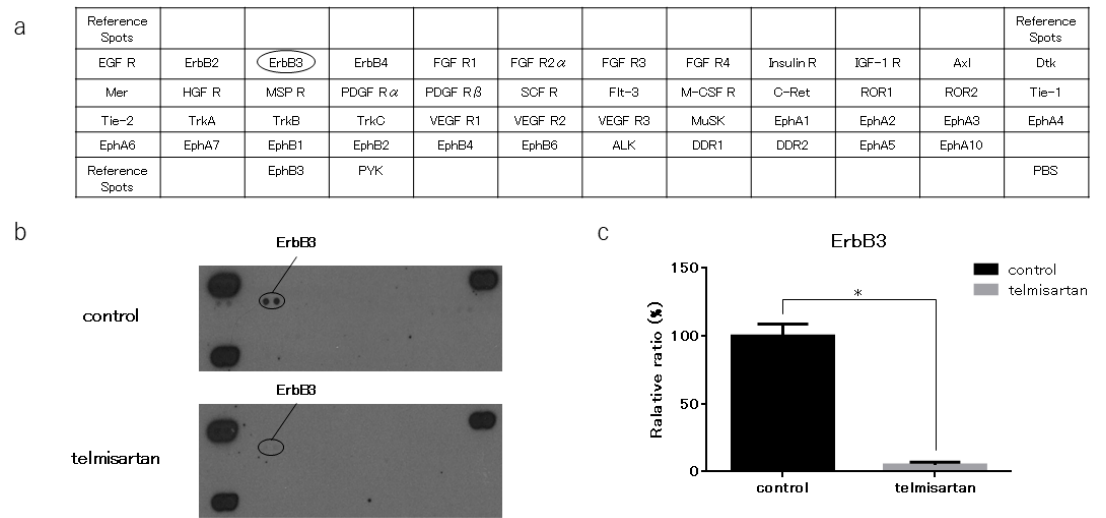
Figure 5. Result of p-RTK array for KYSE180 cells. ( a ) Template shows locations of tyrosine kinase antibodies on human p-RTK array. ( b ) p-ErbB3 expression was decreased in KYSE180 cells treated with 50 µM telmisartan at 24 h. ( c ) Densitometric ratio of telmisartan-treated group to non-treated group for p-ErbB3 spots. * p < 0.01.